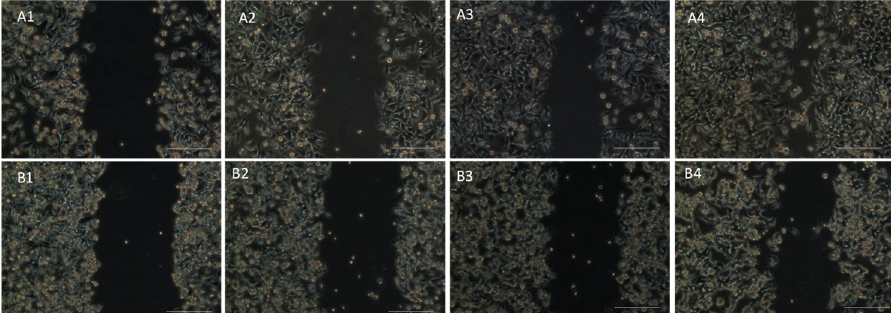
Figure 1. Keratinocyte migration in absence ( A ) and presence ( B ) of P188D peptide over time. 1—before contact, 2—2 h, 3—6 h, 4—24 h, respectively. Scale bar—200 mm.